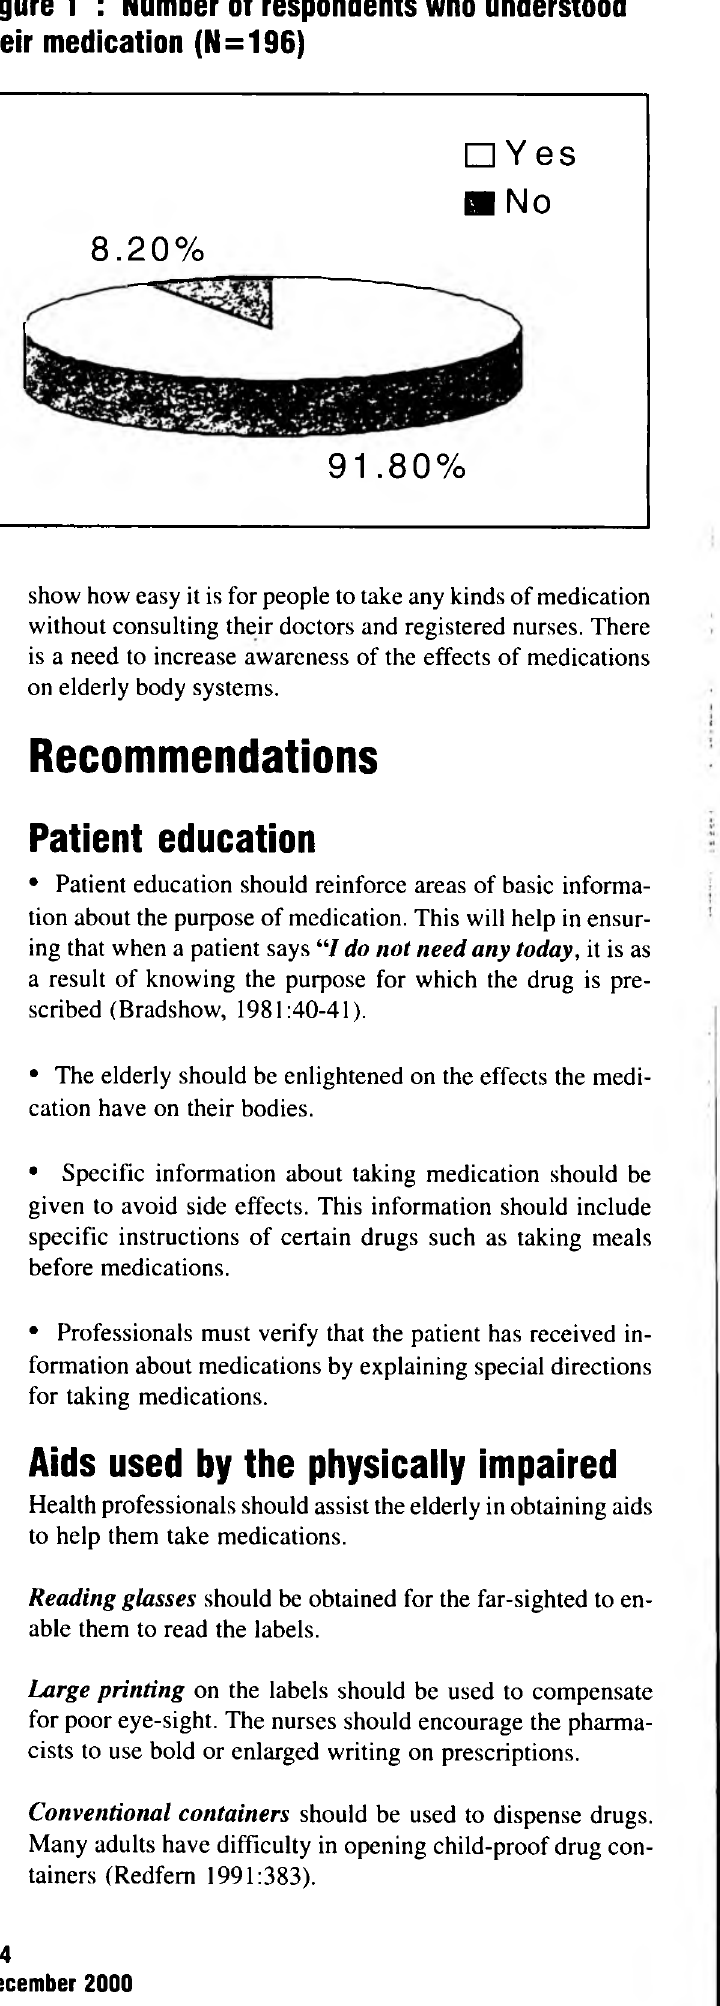
Figure 1 : Number of respondents who understood their medication